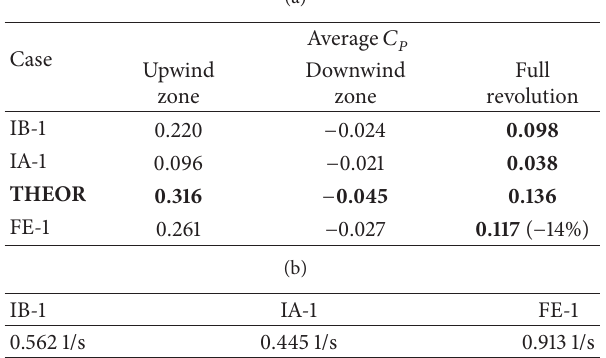
Table 1: (a) Average 𝐶 𝑃 generated during one revolution by one isolated blade (IB-1) and one isolated set of arms (IA-1), along with theoretical (IB-1 plus IA-1) and actual full element (FE-1) results. (b) Average vorticity magnitude in a vertical plane behind the turbine, orthogonal to the free stream velocity (see Figure 10(c)).